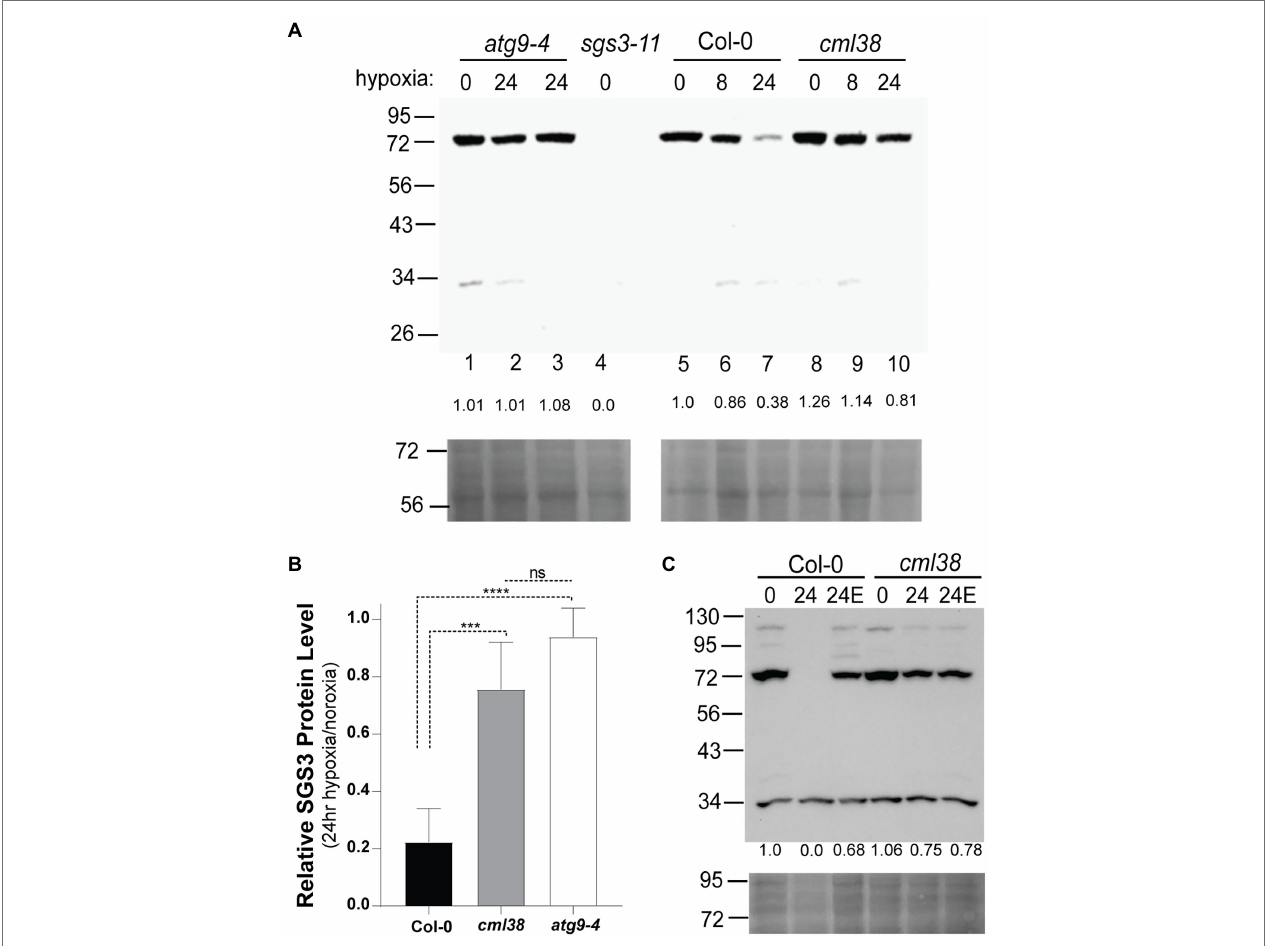
FIGURE 6 | SGS3 protein levels decline during extended hypoxia via CML38-dependent autophagy. (A) SGS3 western blot (antibodies against native A. thaliana SGS3, AgriSera) of root extracts (top) and corresponding Ponceau-S stain (bottom) of the Col-0, cml38 , sgs3-11 , and atg9-4 lines from 40-day old hydroponic A. thaliana plants. Each lane was loaded with 40 μ g total protein based on Bradford analysis. The predicted molecular weight of SGS3 is 71.97 kDa. The numbers at the top of the blot indicate the duration of hypoxia treatment (8 h or 24 h hypoxia or 0 h). Two atg9-4 replicates of 24 h samples are shown in lanes 2 and 3. The numbers below each lane show the densitometric ratio of the signal to wild type normoxia. (B) Relative SGS3 protein levels in 24 hypoxia-treated Col-0 ( n = 8), cml38 ( n = 6), and atg9-4 ( n = 3). Quantitation of the Western signal by densitometry was done followed by standardization of the 24 h signal to normoxic samples. Error bars show SD. Statistical significance was assessed by one way ANOVA analysis (****, p < 0.0001; ***, p < 0.001; ns, not significant). (C) SGS3 western blot (top) and corresponding Ponceau-S stain (bottom) of root extracts of the Col-0 and cml38 under normoxic conditions (0), 24 h hypoxia (24), or 24 hypoxia treated with 10 μ M E64d (24E). The numbers under each lane are the densitometric ratio to wild type